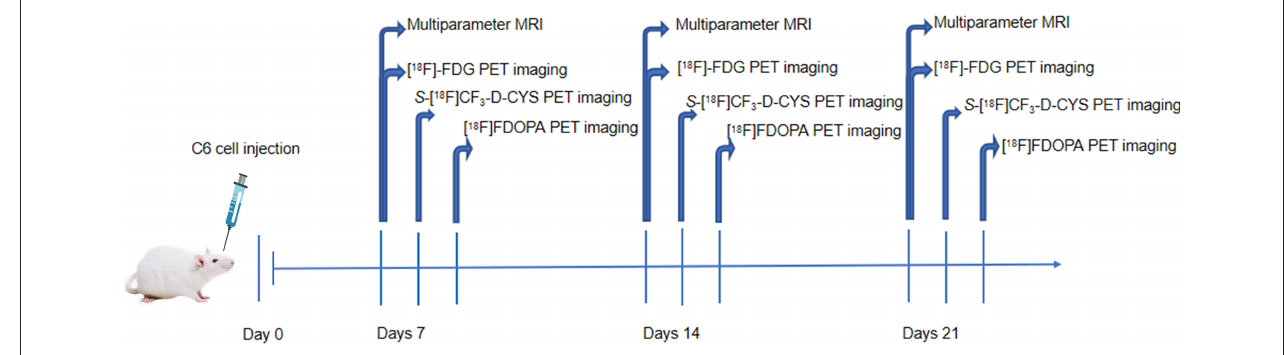
FIGURE 1 | The outline of this